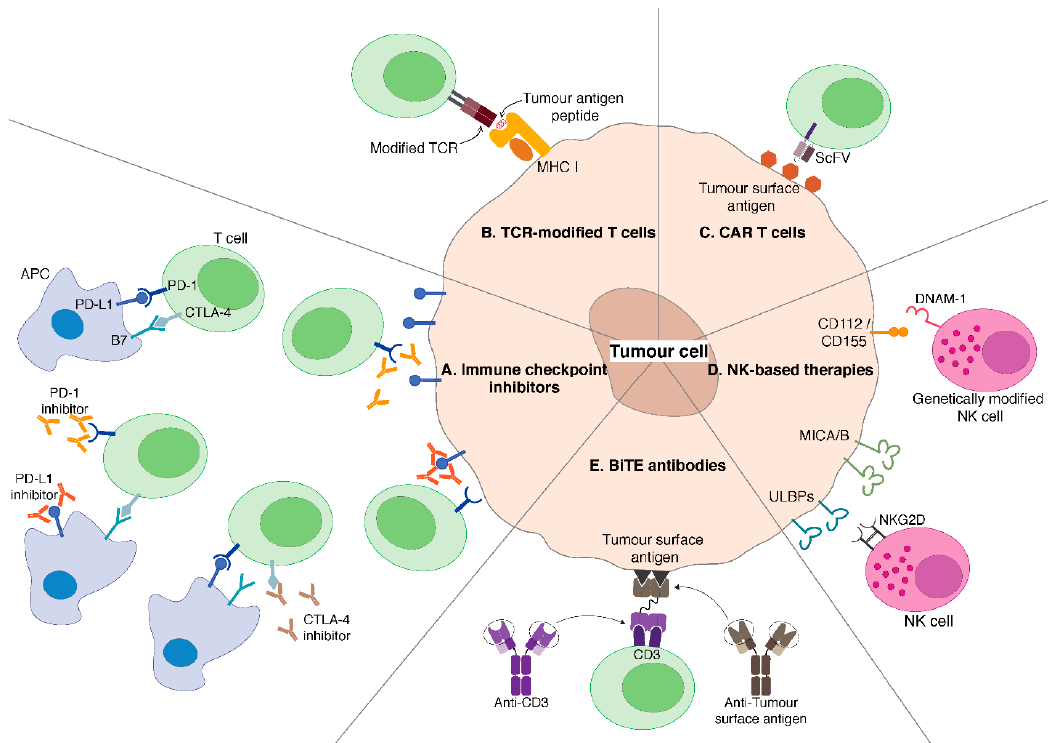
Figure 1. Overview of the different types of T cell and NK cell-based immunotherapies developed for sarcoma treatment. ( A ) The immune checkpoint ligands, PD-L1 and CTLA-4 are expressed on APC and T cells, respectively. Upon engaging with their respective receptors, PD-1 on T cell and B7 on APC, the negative signals dampen the functions of these immune cells thereby preventing the generation of anti-tumour immune responses. PD-L1 can also be overexpressed on tumour cells and prevent T cell-mediated killing. Immune checkpoint inhibitors targeting PD-1, PD-L1 or CTLA-4 can interfere with the engagement between ligands and receptors thereby allowing T cell activation and generation of immune response against tumour cells. ( B ) T cell modified to express TCR against a specific TAA peptide presented on MHC molecules to aid in tumour recognition by the immune cells. ( C ) T cell modified to express CAR, which consists of a monoclonal antibody’s scFv and an intracellular signalling domain, against a specific TAA protein on the tumour cell surface thereby overcoming the issues associated with downregulation of MHC molecules on tumour cells. ( D ) NK cells express activating receptors such as NKG2D and DNAM-1 and they bind to activating ligands, MICA/B, ULBPs and CD112, CD155, respectively, on the tumour cells. NK cells can also be genetically modified to express activating receptors. ( E ) BiTE antibody consists of two domains; one domain recognises TAA on the tumour cell and the second domain recognises CD3 receptor on the T cell, leading to T cell activation. NK, natural killer; PD-L1, programmed cell death-ligand 1; CTLA-4, cytotoxic T-lymphocyte-associated protein 4; PD-1, programmed cell death protein 1; APC, antigen presenting cell; TCR, T cell receptor; TAA, tumour-associated antigen; MHC, major histocompatibility complex; CAR, chimeric antigen receptor; scFv, single-chain variable fragment; BiTE, bispecific T cell engager.